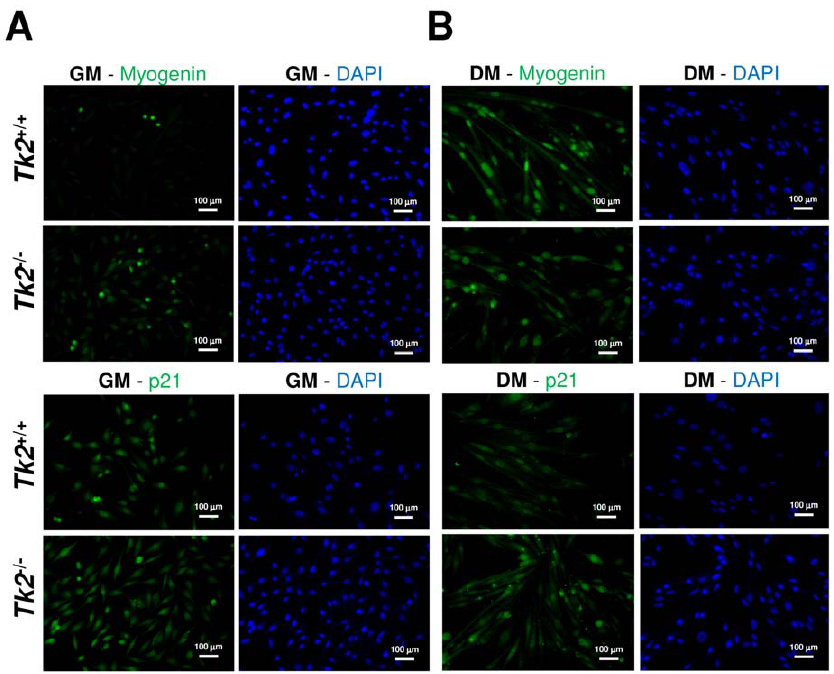
Figure 6. Tk2 + / + and Tk2 2 / 2 primary myoblasts culture and differentiation. A ) Primary myoblasts were isolated from 1–2 days old wild-type ( Tk2 + / + ) and Tk2 knockout ( Tk2 2 / 2 ) pups and cultured according to standard methods. Cultured primary myoblasts in F-10/DMEM-based primary